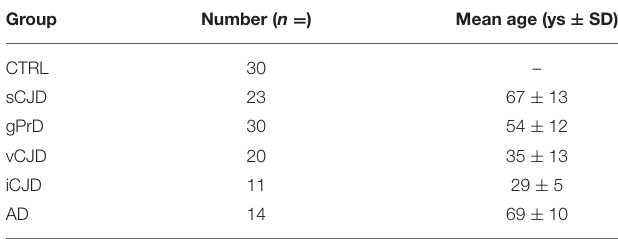
TABLE 1 | Summary of sample groups used in the